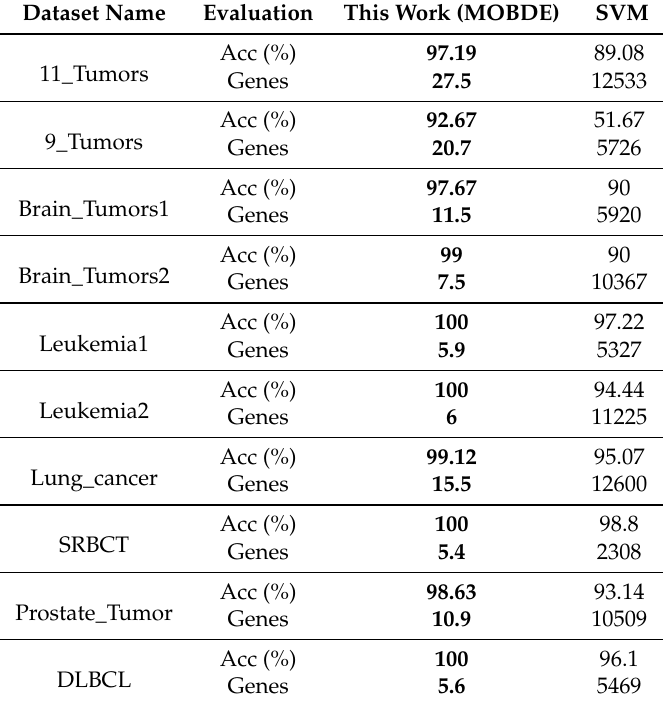
Table 10. Comparative experimental results of the binary differential evolution algorithm with grid search support vector machine